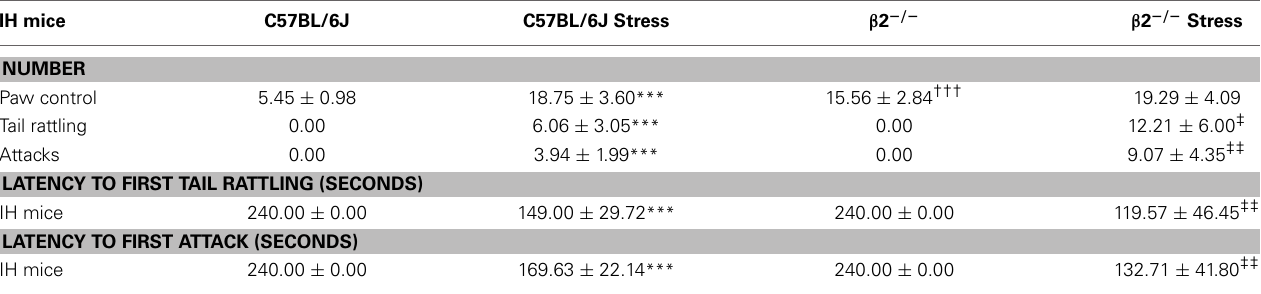
Table 2 | Dominance and aggressiveness during social